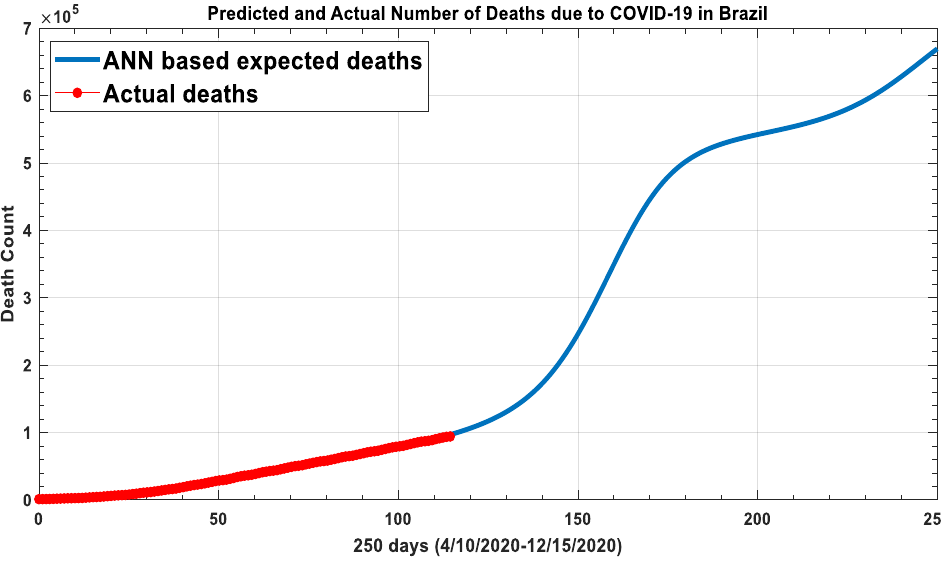
Figure 5. The training data and predicted data of COVID-19 deaths in Brazil.